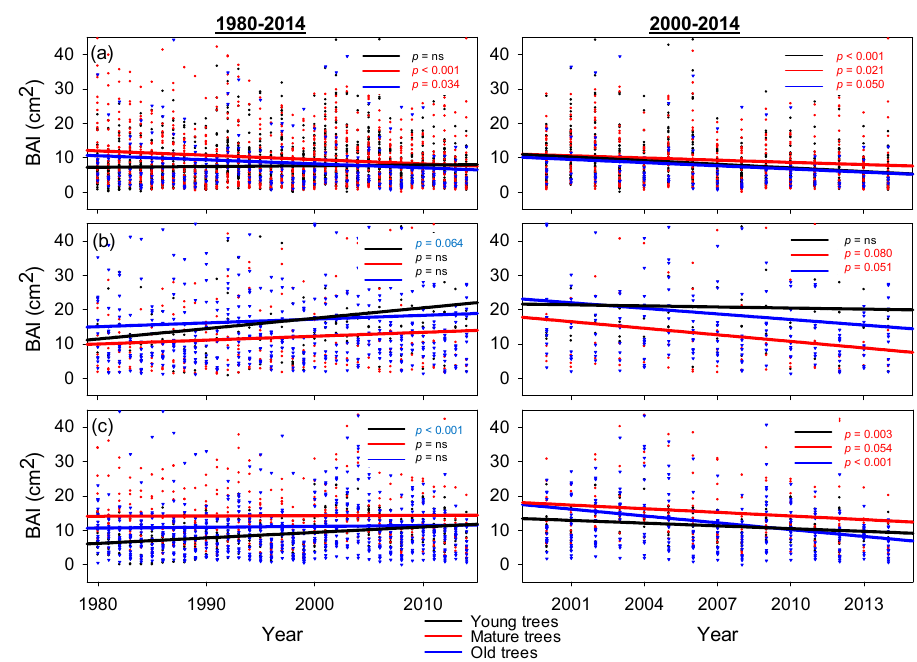
Figure 4. Growth trends of the basal area increment (BAI) of N. macrocarpa , according to the cluster population and age classes for the period from 1980 to 2014 and 2000 to 2014. Values of ‘ p ’ in blue indicate positive significant linear trends (at a significant level of 90%), and, in red, the negative linear trends. ( a ) Coastal, ( b ) Highest, and ( c ) Andes.